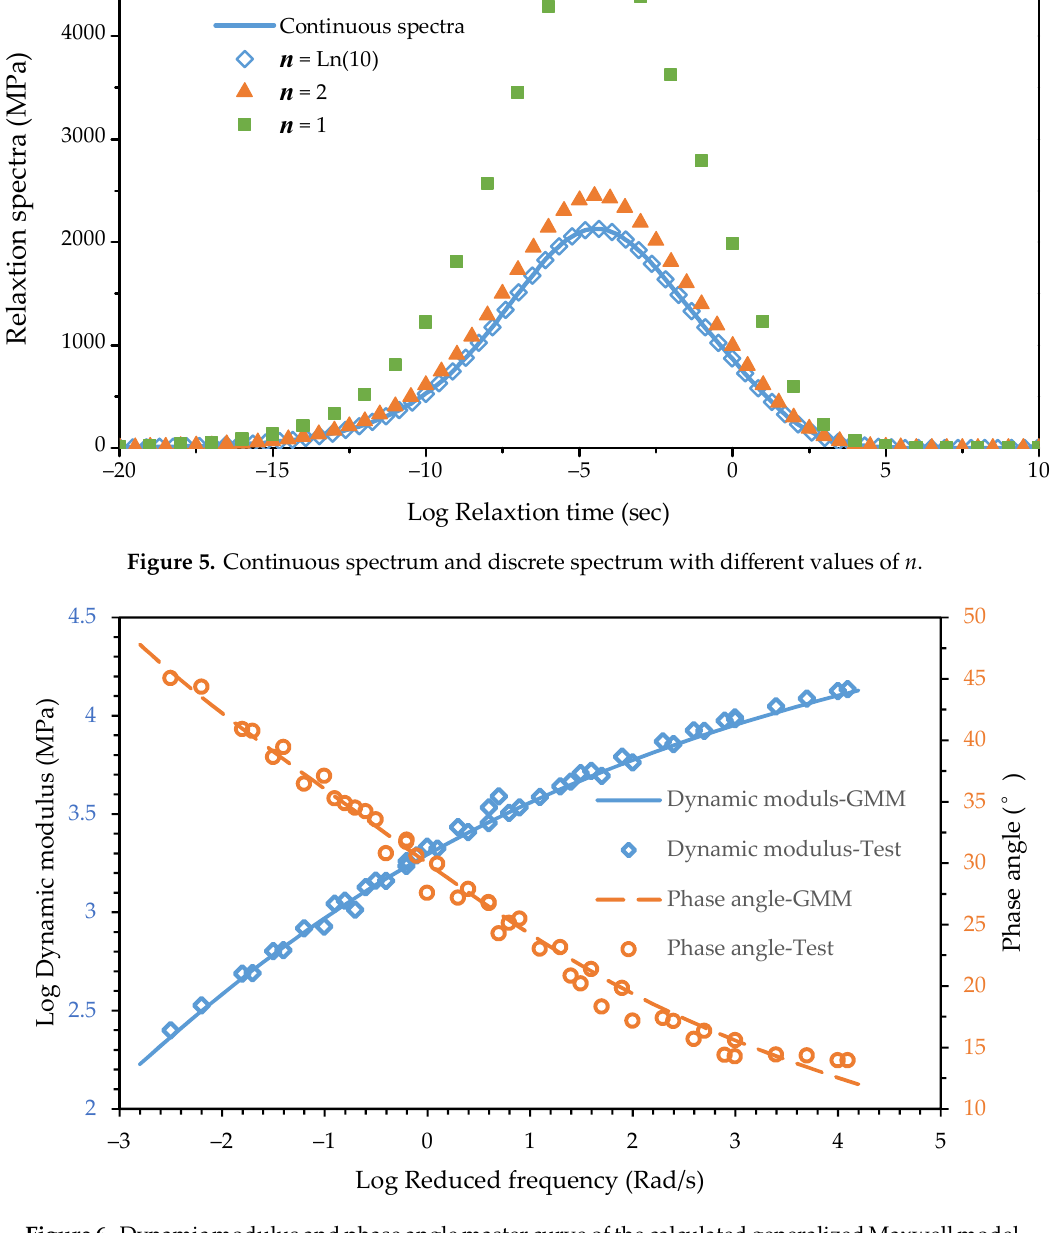
Figure 6. Dynamic modulus and phase angle master curve of the calculated generalized Maxwell model.